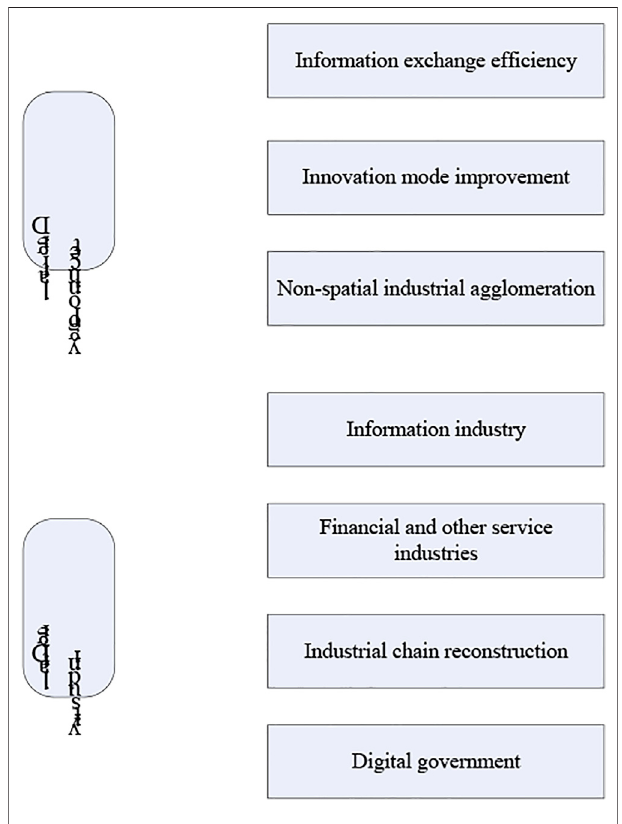
FIGURE 1 | Classi fi cation of the digital